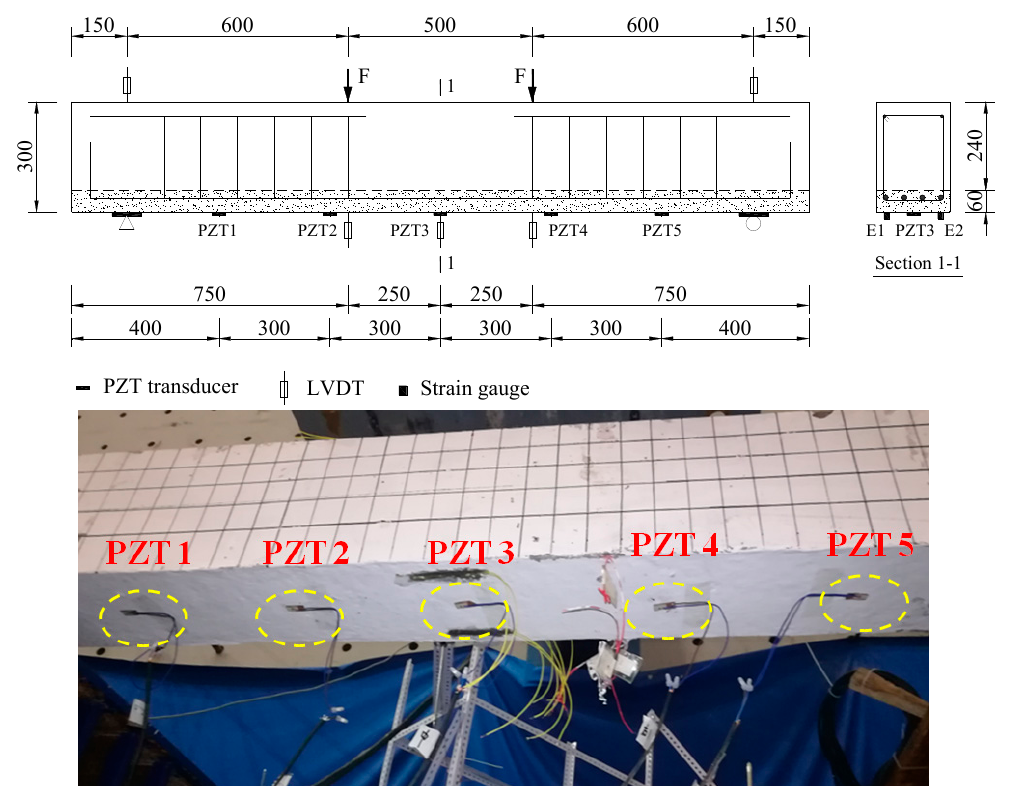
Figure 3. Schematic test setup and layout of LVDTs and PZT sensors on the beams (unit: mm).